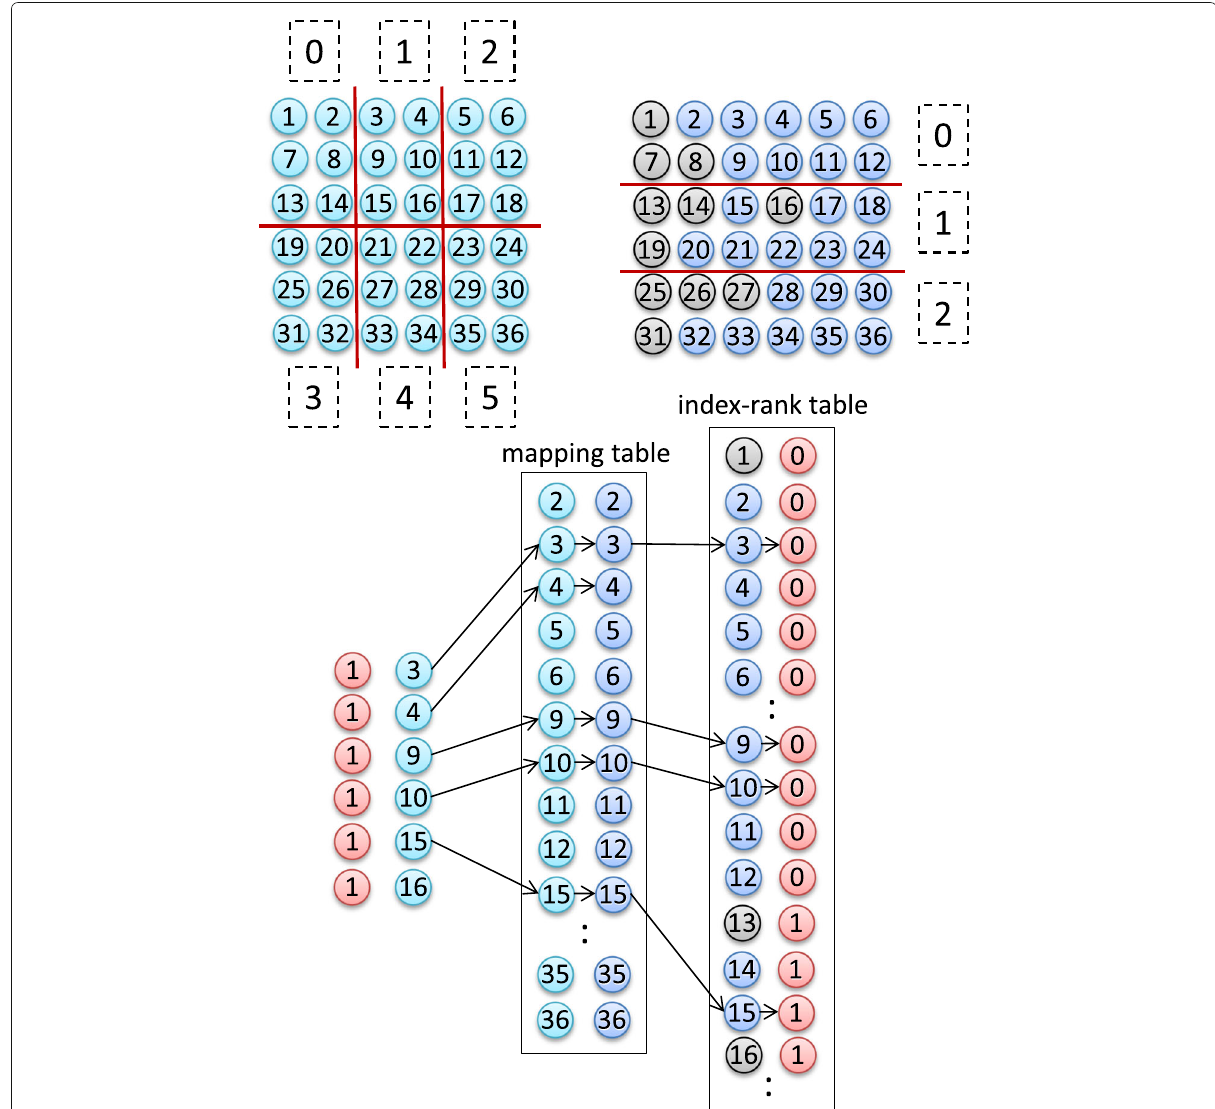
Fig. 3 Example of how to calculate the rank of target component. Left square indicates the grid point indexes of rank 1. Center square is a mapping table and right square is an index-rank table of target component